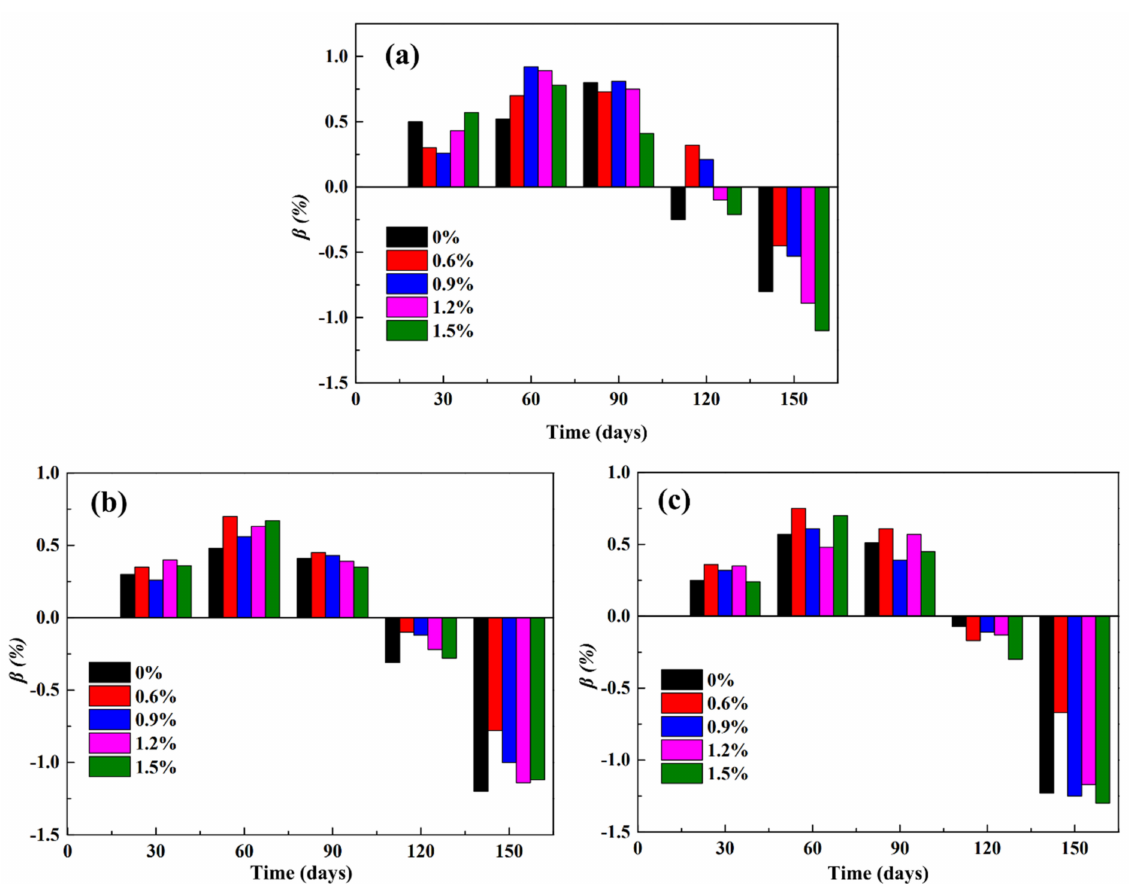
Figure 7. The mass loss rate of PP fiber mortar specimens treated with different C/S ratios: ( a ) 1:1; ( b ) 1:1.5; ( c )